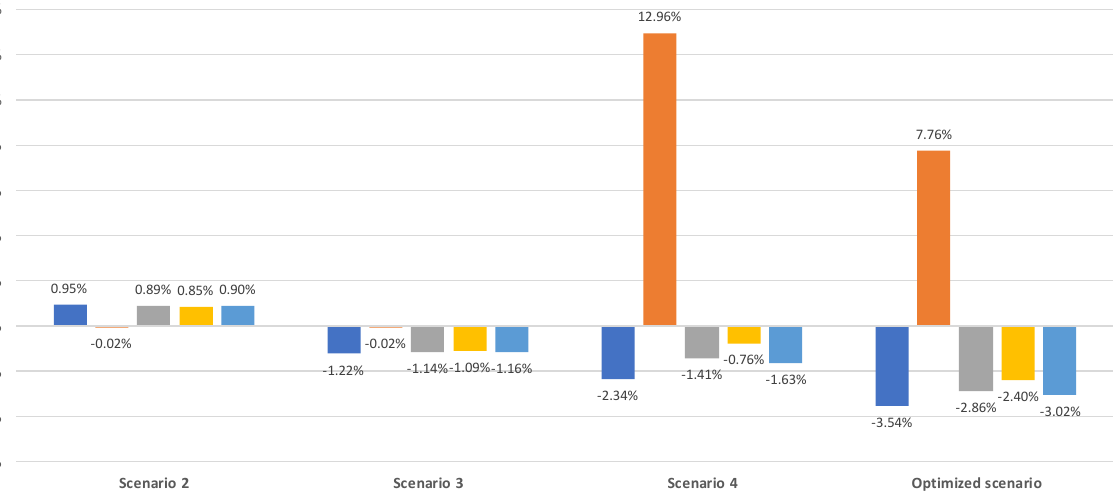
Figure 9. Indoor temperature according to the set-point 19  21 °C, percentage of time in different users, comparison of scenarios (Scenario 1 in green, Scenario 2 in blue, Scenario 3 in yellow, and Scenario 4 in red).